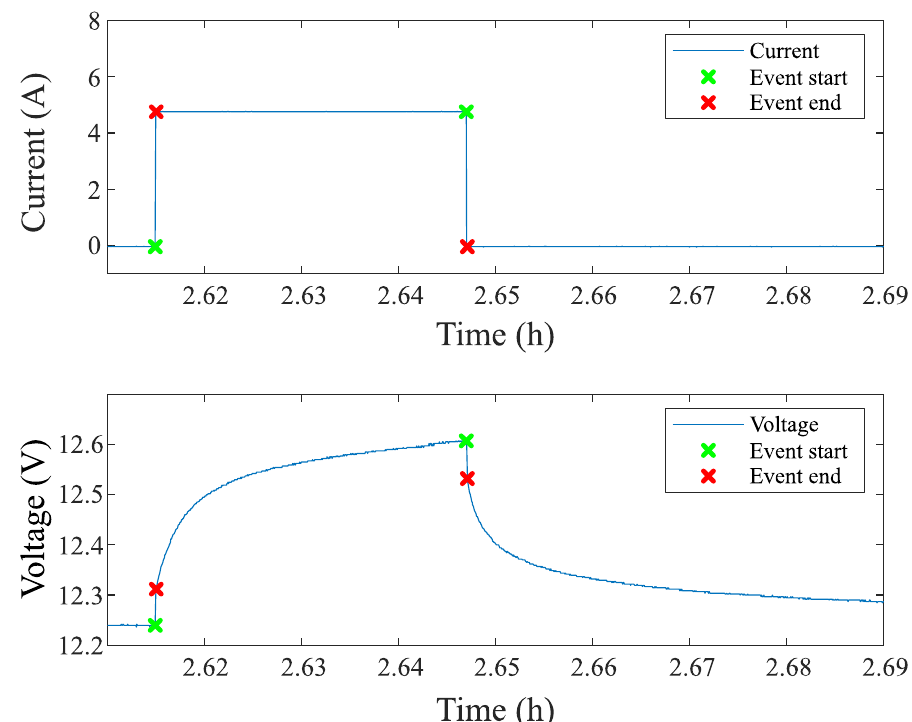
Figure 8. Identification of current pulses and voltage relaxation events.